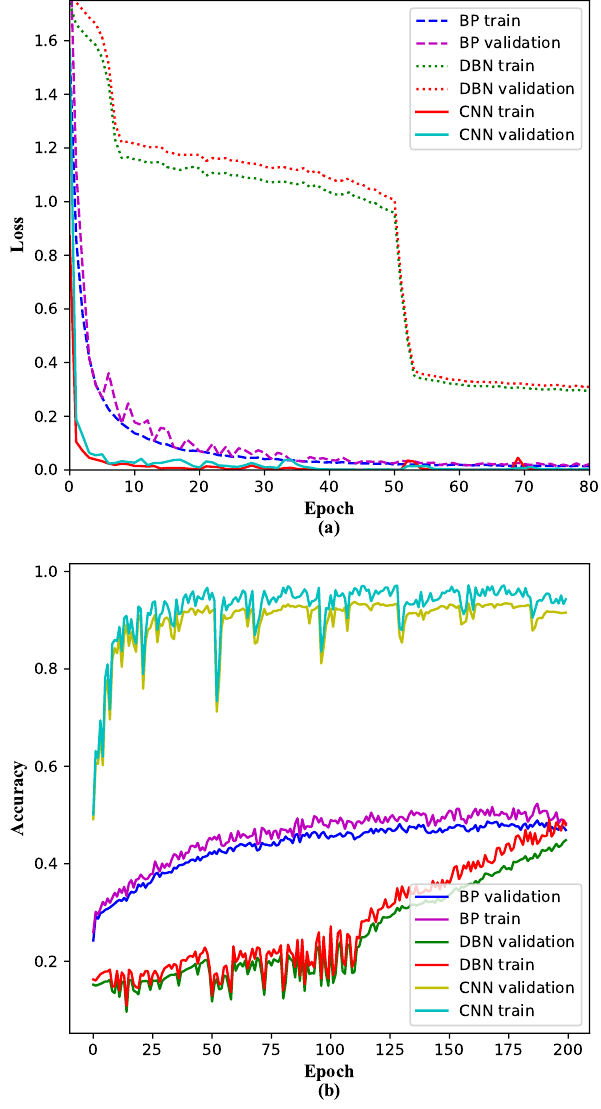
Figure 4. The diagnostic networks’ training curve in 1:50 balance ratio: ( a ) the loss curve of the training set and validation set ( b ) the accuracy curve of the validation set and training